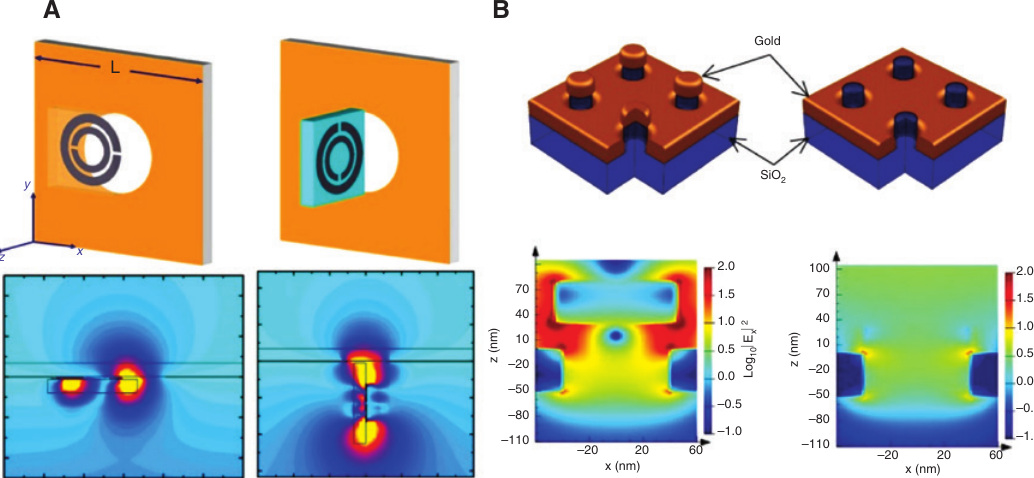
Figure 30: Boosted field enhancements by localization of incident/transmitted light by using additional plasmonic couplers. (A) Coupling with split-ring-resonators, and (B) plasmonic islands. A and B are reproduced from Refs. [322] and [323],